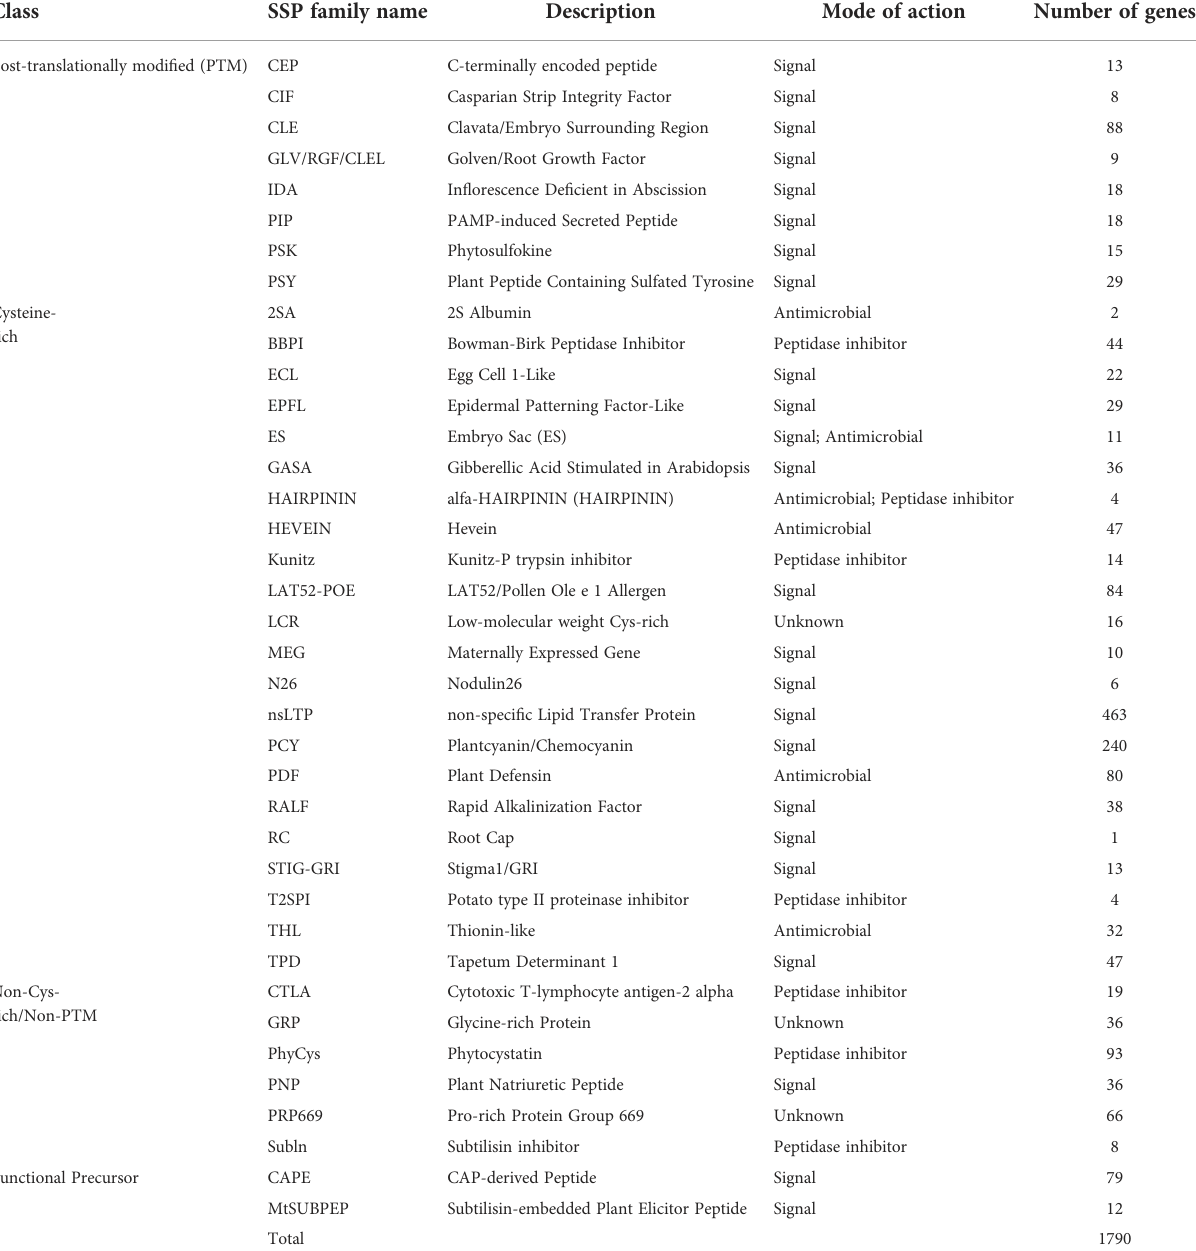
TABLE 1 Predicted SSP families in